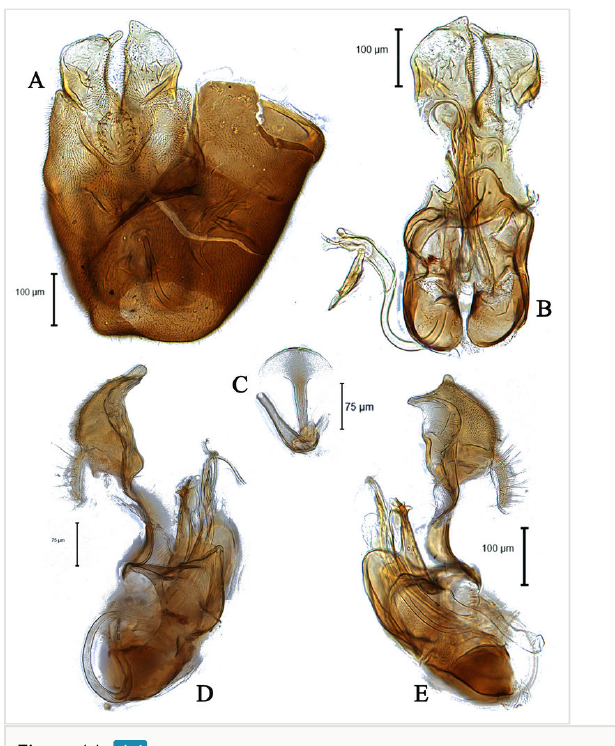
Figure 14. Male genitalia of Eudorylas fluviatilis (JSS52195) (A) in dorsal view; (B) in ventral view; (C) ejaculatory apodeme; (D, E) in lateral